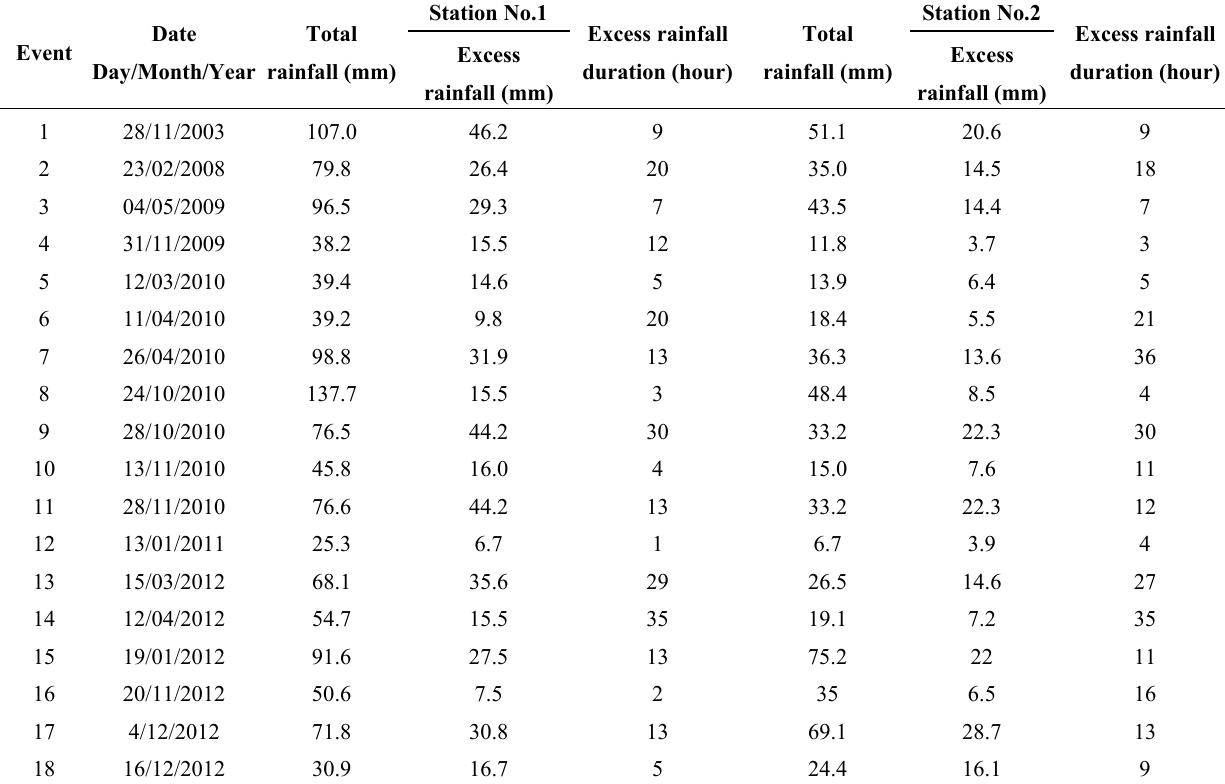
Table 3. Characteristics of used